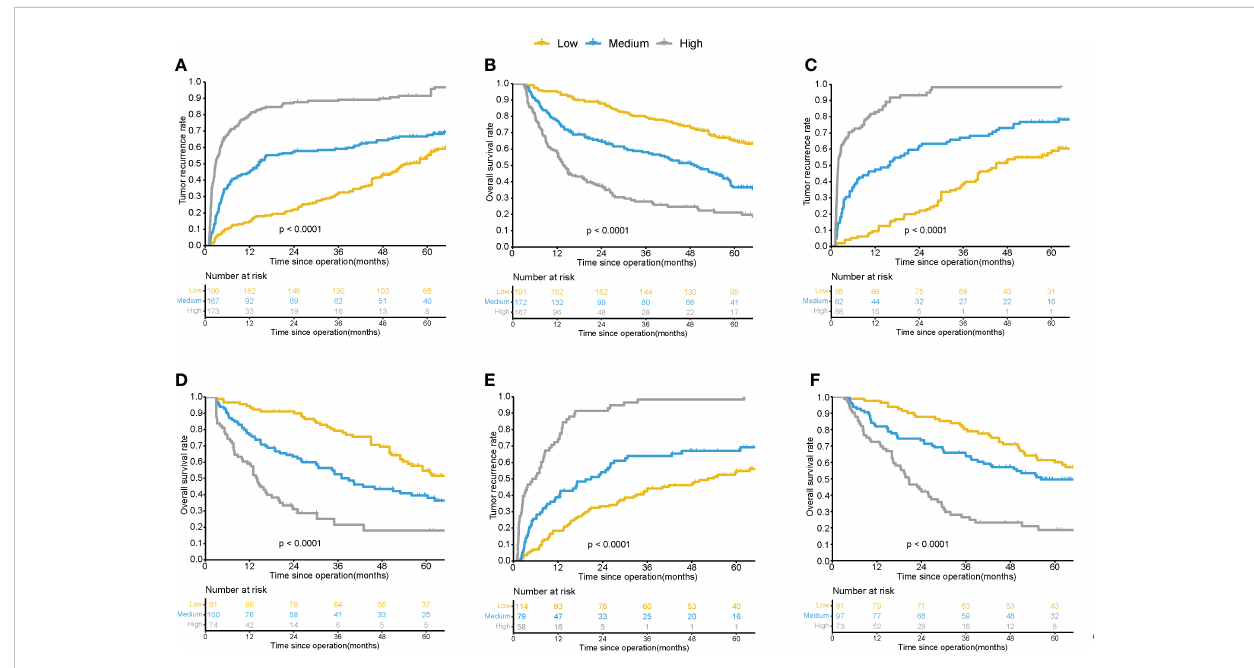
FIGURE 4 Kaplan-Meier survival curves for patients with different risk of postsurgical recurrence and OS by the nomogram score in training cohorts (A, B) , internalvalidation cohorts (C, D) and external validation cohorts (E, F)